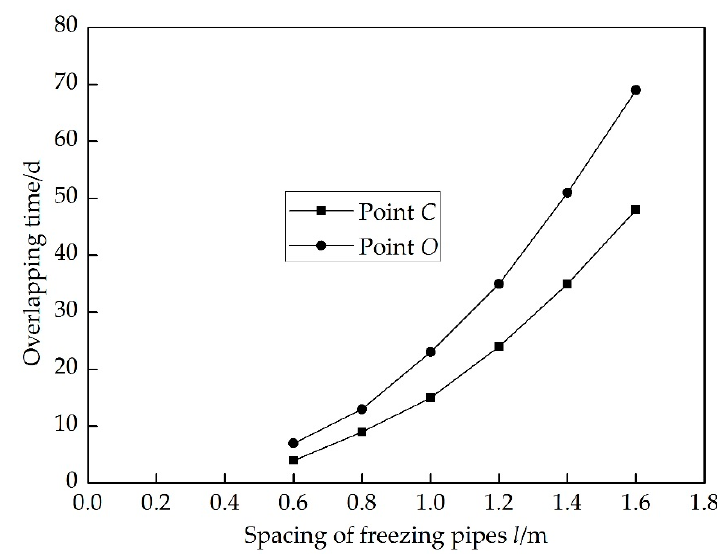
Figure 13. Relationship between the overlapping time and the spacing of freezing pipes.